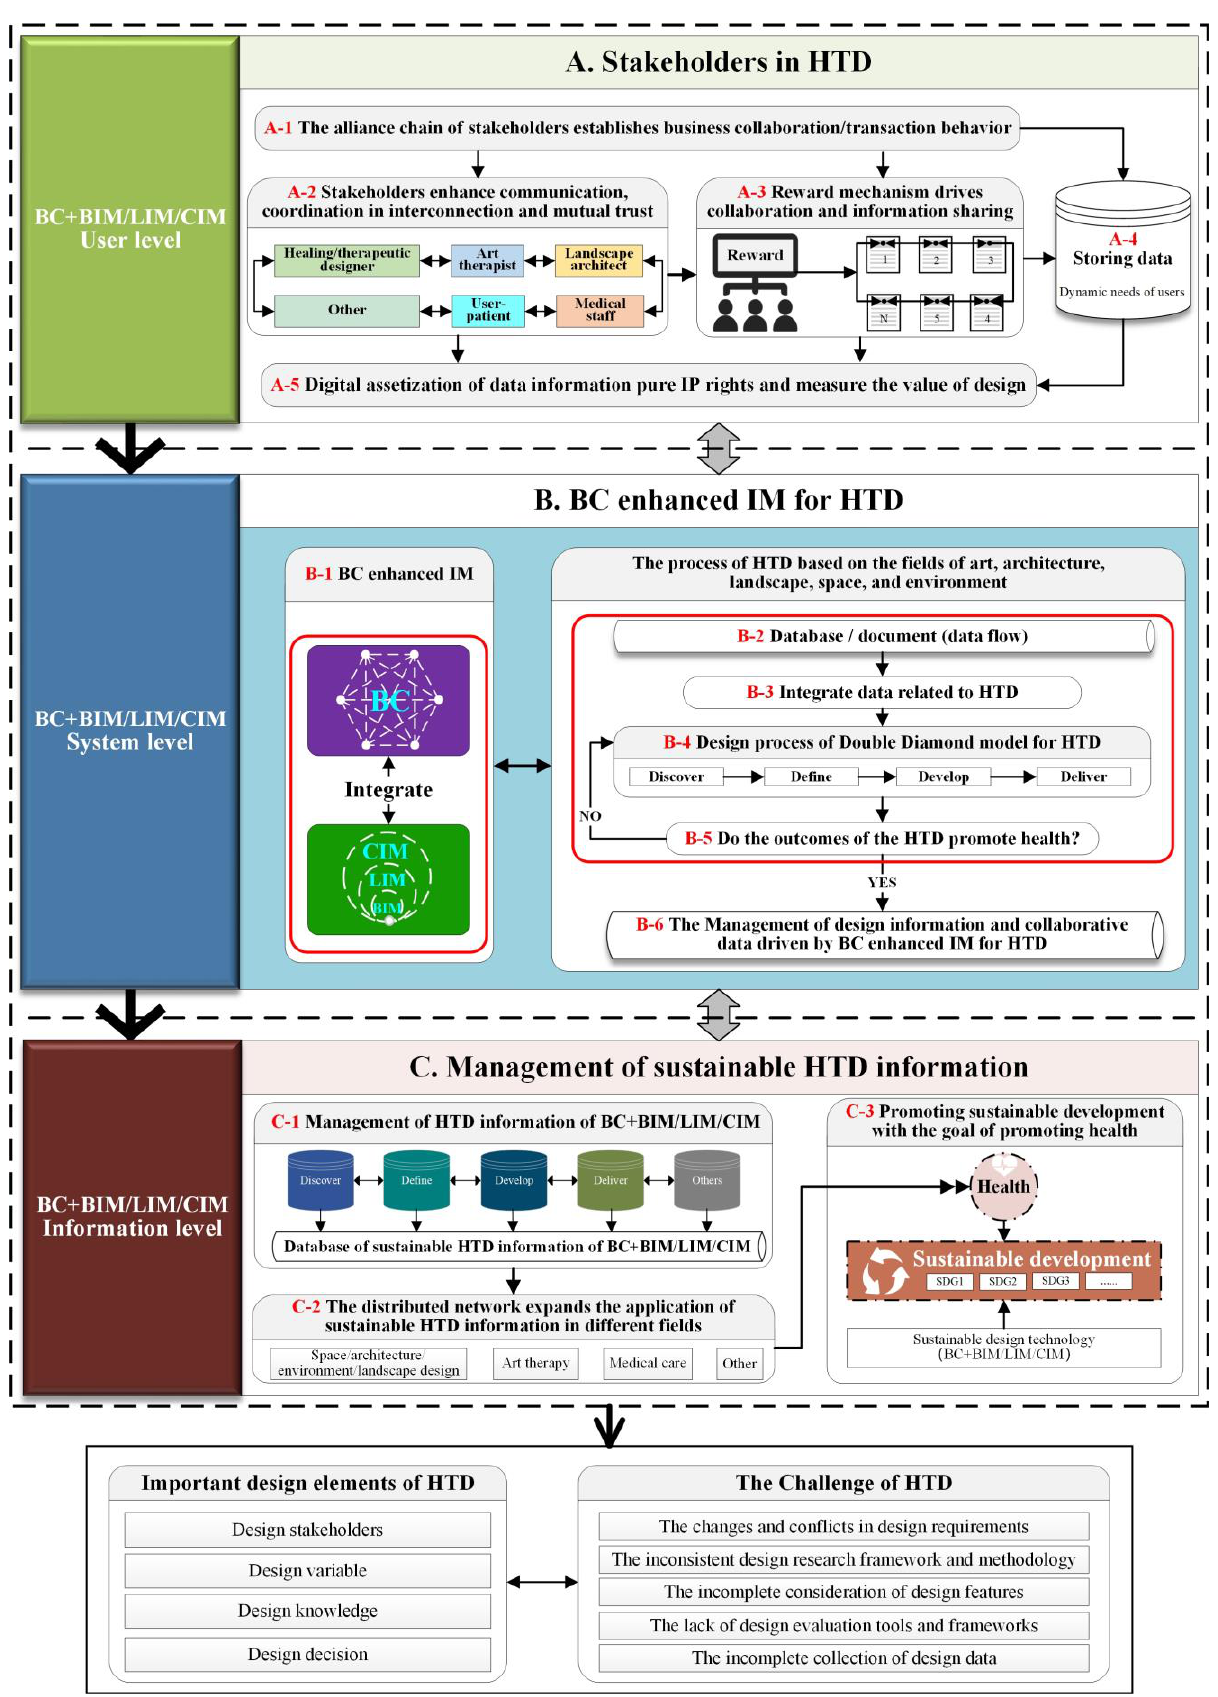
Figure 11. Updated high-level BC-HTD framework (generated by authors).